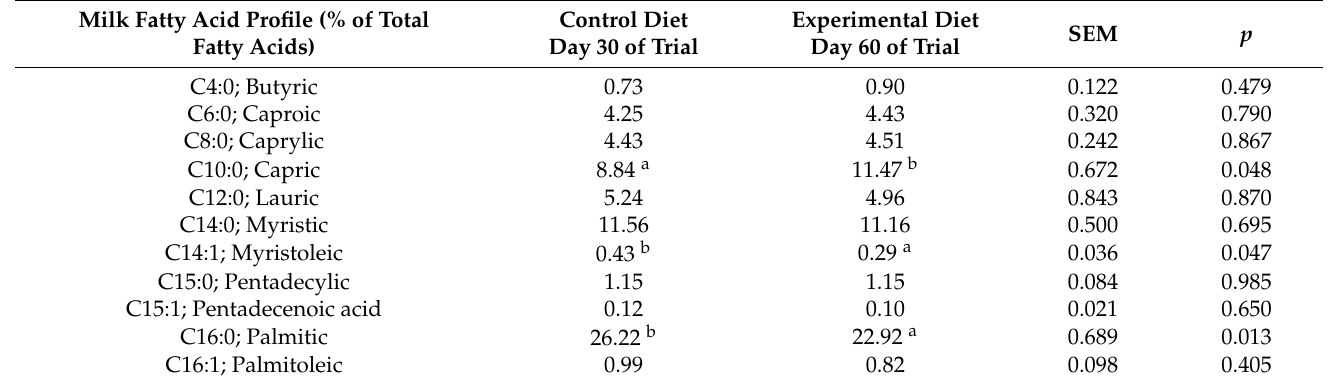
Table 3. Effect of dietary supplementation on milk fatty acid